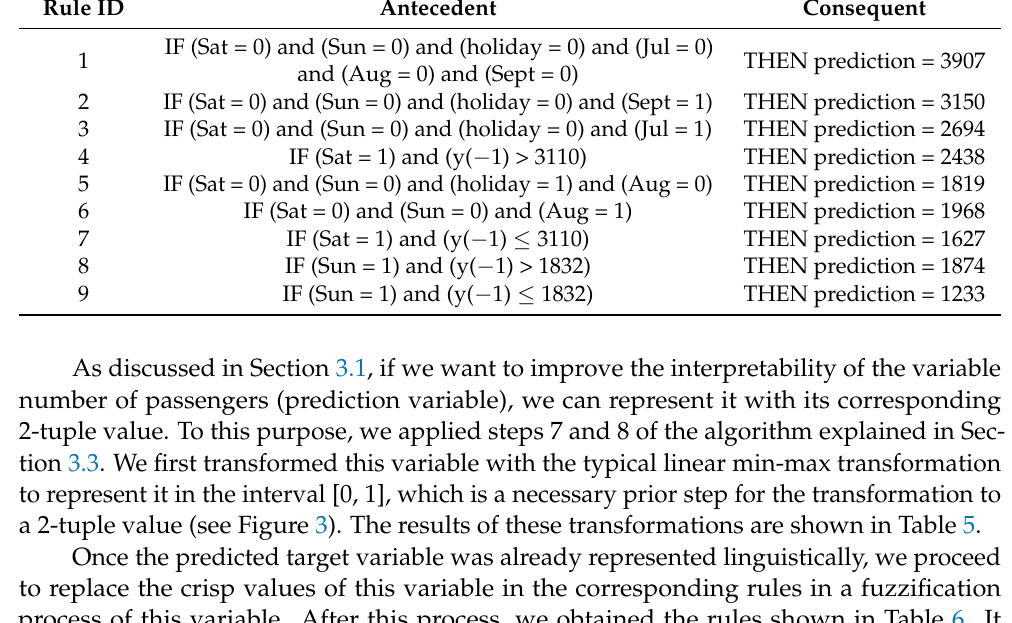
Table 5. 2-tuple representation of the predicted target variable.